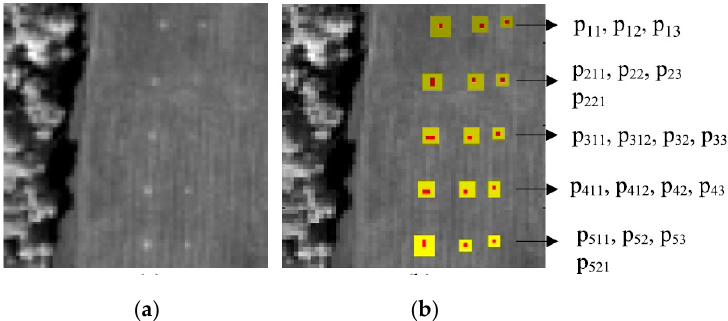
Figure A1. ( a ) A hyperspectral digital imagery collection (HYDICE) panel scene which contains 15 panels; ( b ) ground truth map of the spatial locations of the 15 panels.